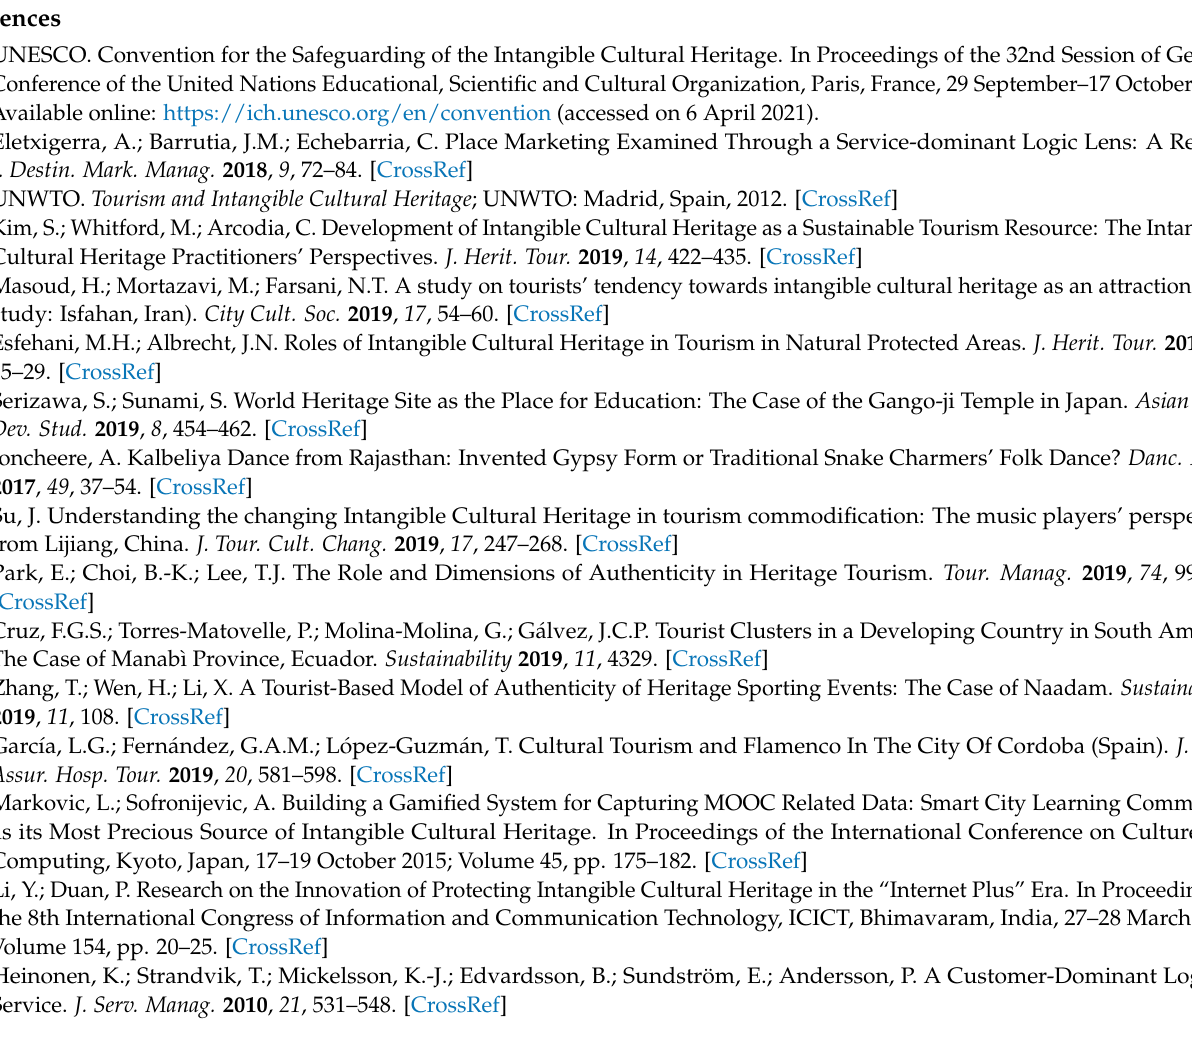
Figure A4. Government adopts local folk dance as a city brand.